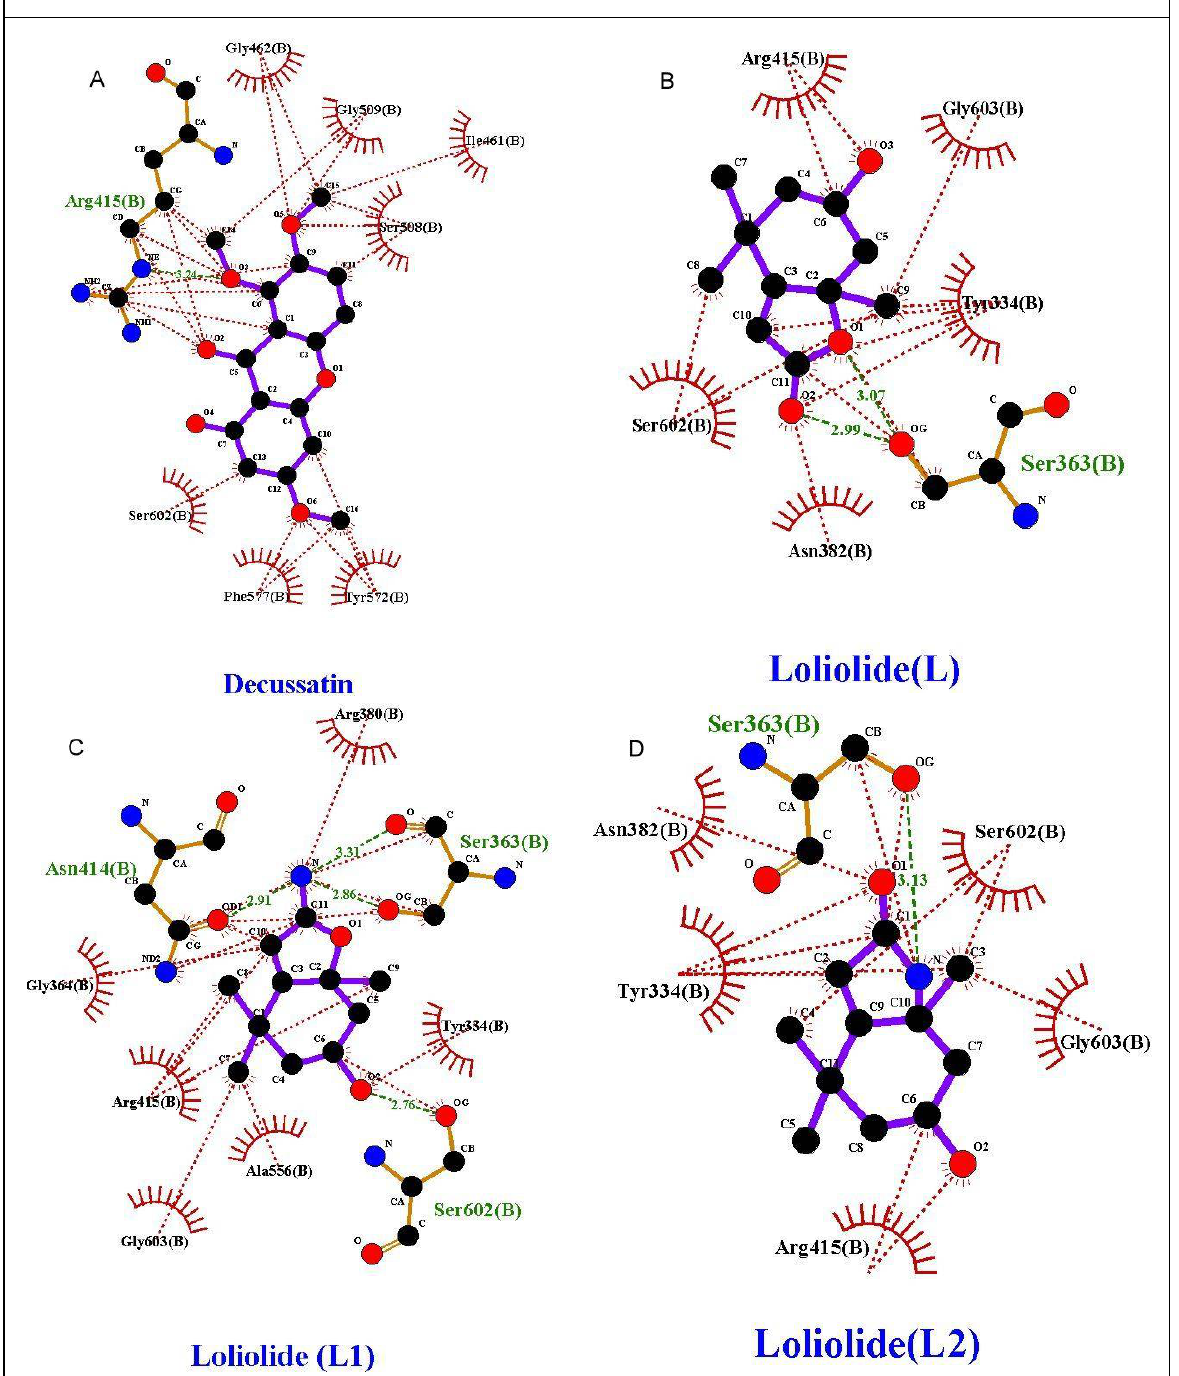
Figure S4: The two-dimensional illustrations of the interaction analysis of the individual ligands with the Kelch domain of the Keap1 protein as obtained from